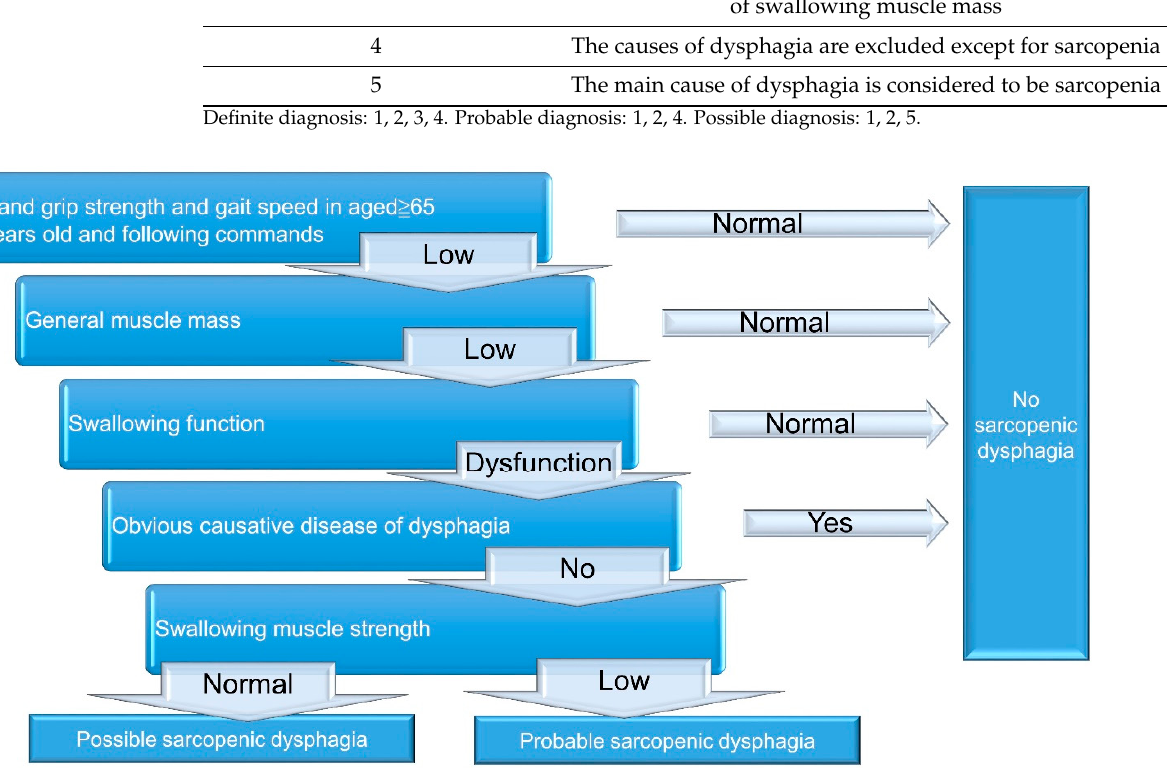
Figure 2. A 5-step diagnostic algorithm for the diagnosis of sarcopenic